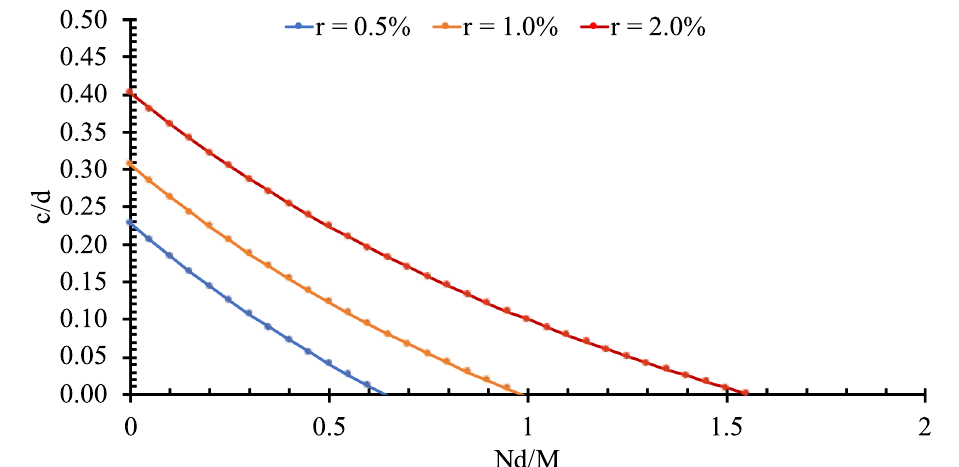
Figure 5. The effect of tension forces on the compression zone depth of elements with different reinforcement ratios ( f c ′ = 30 MPa and M / Vd =